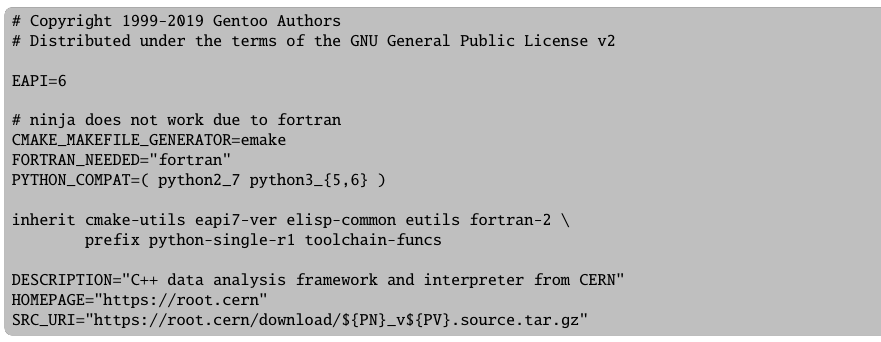
Figure 5. Example ebuild for CERN ROOT. The script starts with a declarative header to specify properties of the piece of